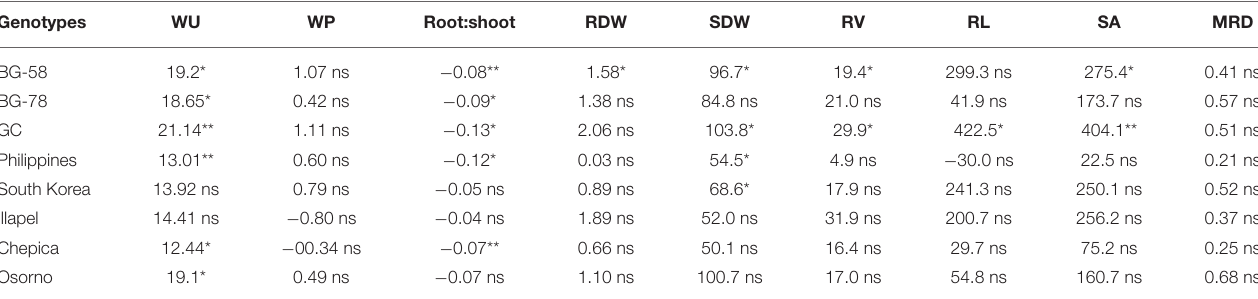
TABLE 2 | Orthogonal contrasting test for the difference of mean values between water-deficit (WD) and well-watered (WW) conditions for the water consumption (WU), water productivity (WP), root and shoot biomass (RDW and SDW, respectively), and root traits (RL, Root length; MRD, Mean Root Diameter; RV; Root Volume; SA, Surface Area) evaluated in eight bottle gourd